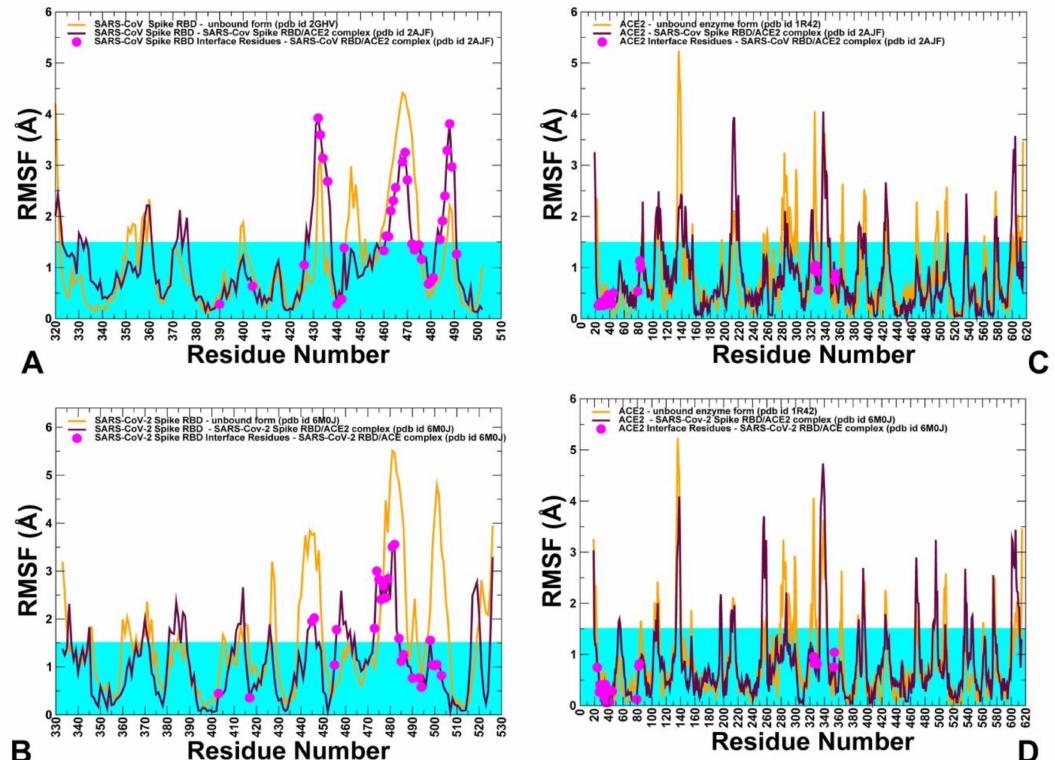
Figure 7. All-atom conformational dynamics of the unbound and bound SARS-CoV structures. The root mean square fluctuations (RMSF) profiles are obtained from all-atom MD simulations of the crystal structures. ( A ) Conformational dynamics profiles of the unbound SARS-CoV (pdb id 2GHV) (in orange lines) and SARS-CoV-RBD in the complex with ACE2 (pdb id 2AJF) (in maroon lines). The positions of the SARS binding interface residues are highlighted in magenta filled circles. ( B ) The RMSF dynamics profiles of the unbound SARS-CoV-2 (in orange lines) and SARS-CoV-2 RBD in the complex with ACE2 (pdb id 6M0J) (in maroon lines). The positions of the SARS binding interface residues are highlighted in magenta filled circles. ( C ) The RMSF dynamics profiles of the unbound ACE2 (pdb id 1R42) (in orange lines) and in the complexes with SARS-CoV-RBD (in maroon lines). The ACE2 binding interface residues are shown in magenta filled circles. ( D ) The RMSF dynamics profiles of the unbound ACE2 (pdb id 1R42) (in orange lines) and in the complexes with SARS-CoV-2 RBD (in maroon lines). The ACE2 binding interface residues are shown in magenta filled circles. The horizontal lines on all graph panels are materialized in cyan to indicate thresholds used to di ff erentiate small and higher thermal